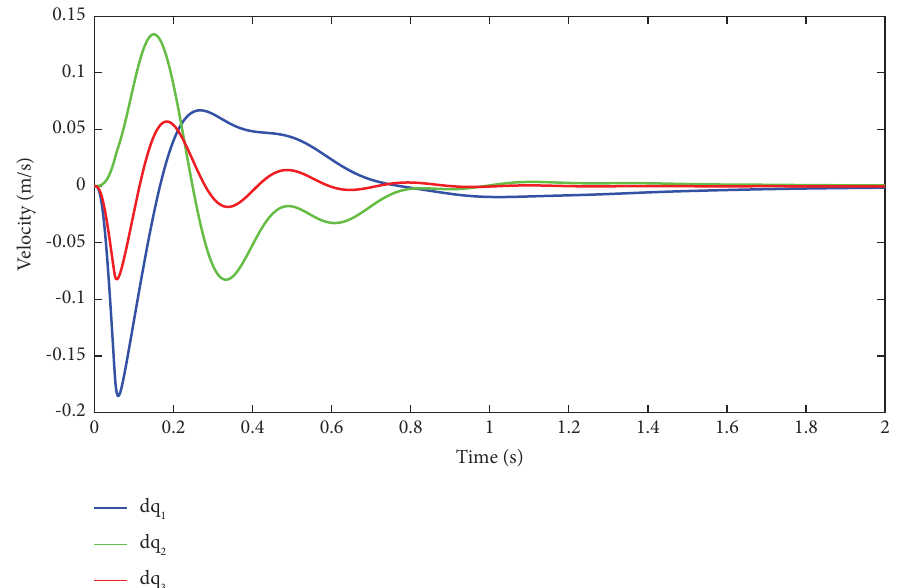
Figure 6: Velocities of the parts of mobile antiaircraft weapon system after the launch: dq dq 2 -vertical velocity of rear suspension of the truck, and dq 3 -vertical velocity of the truck’s mass center.